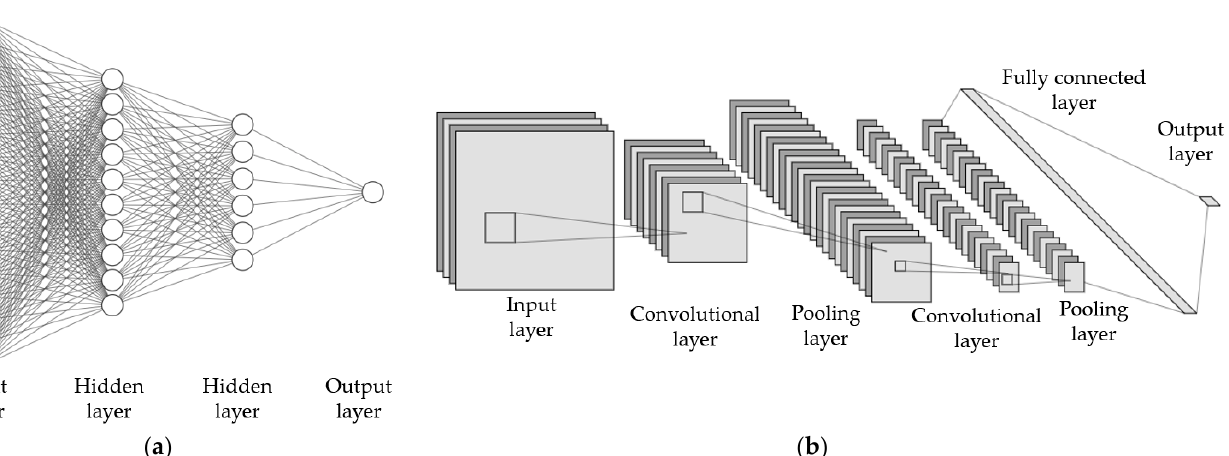
Figure 7. The basic framework of the neurons in the neural network of ( a ) an example of FCNN model and ( b ) an example of CNN model.